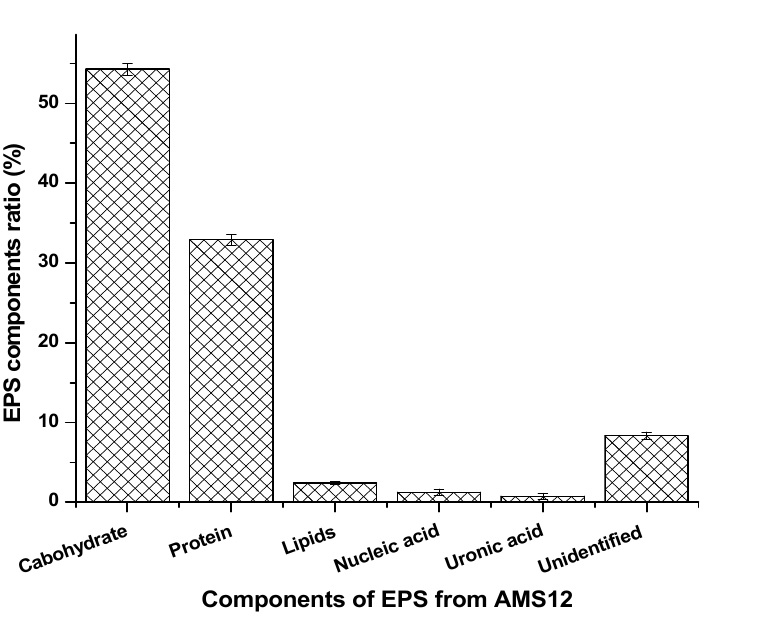
Figure 6. Components of EPS from marine archaea Halococcus sp. AMS12.